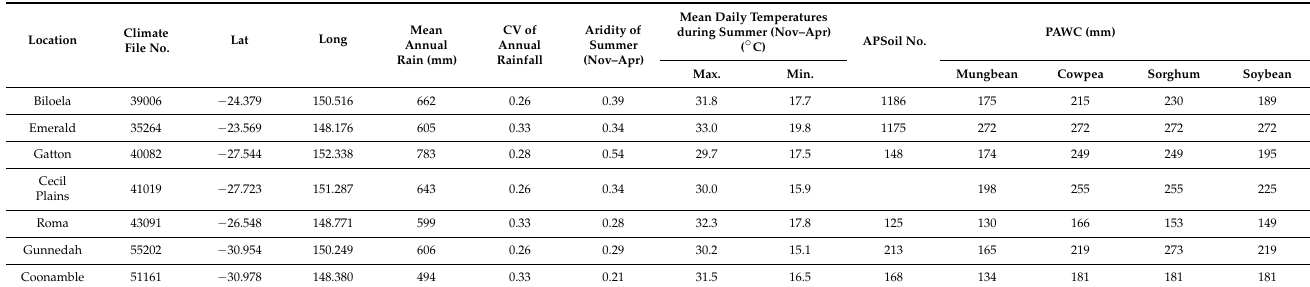
Table 1. Details of climate information (mean and co-efficient of variation (standard deviation/mean) of annual rainfall, summer growing season mean daily maximum and minimum temperatures and aridity (rainfall/potential evapotranspira- tion) and soil type (APSoil number and Plant-available Water-holding Capacity, PAWC) at each location used for long-term simulations of relative potential yields of cowpea and other tropical grain legumes. Location Climate FileNo.